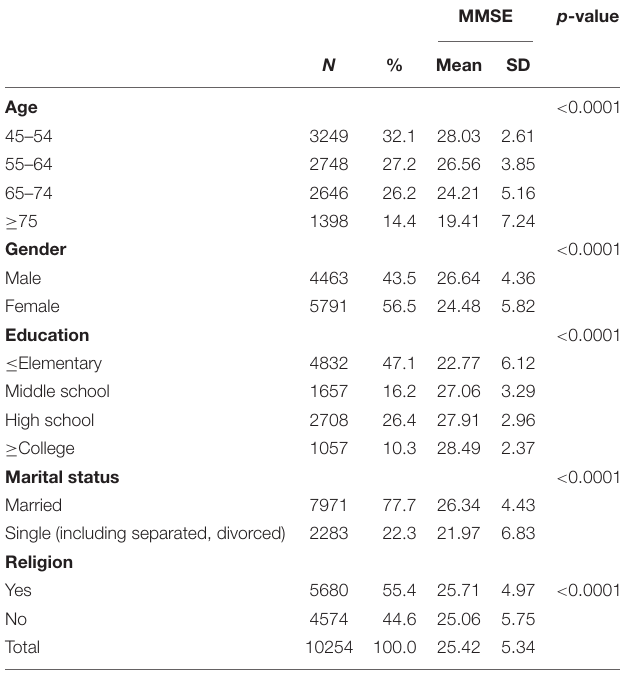
TABLE 2 | T tests and ANOVA in MMSE for socio-demographic variables.